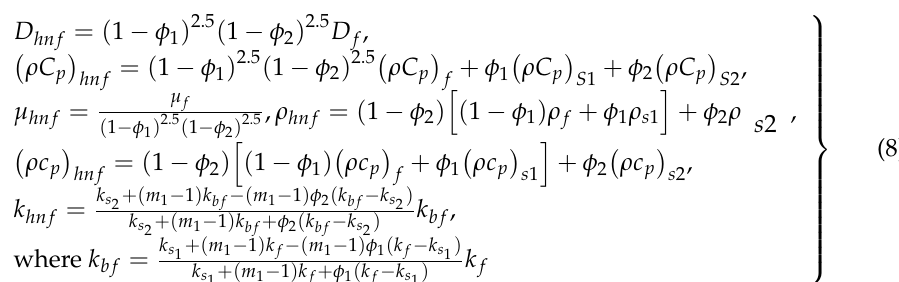
Table 1. Thermophysical properties of nanoparticles and water. Particles ρ ( kg/m 3 ) c p ( J/kg K ) k ( W/mK ) Fe 3 O 4 5180 670 9.7 Go 1800 717 5000 Water 997.1 4179 0.613 The efficient characteristics of hybrid nanofluid are stated